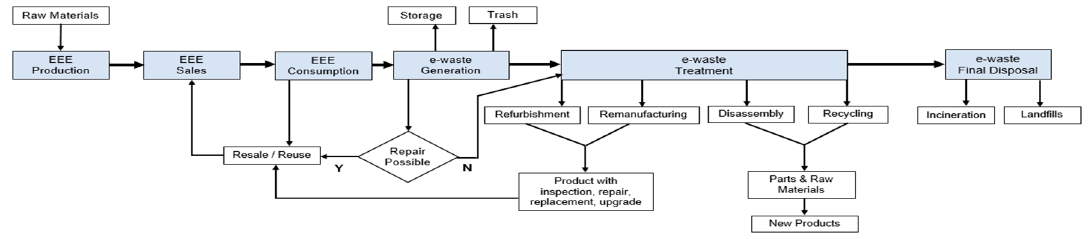
Figure 1. The lifecycle of electrical and electronic equipment (EEE) in Mexico. Source : Córdova- Pizarro et al.